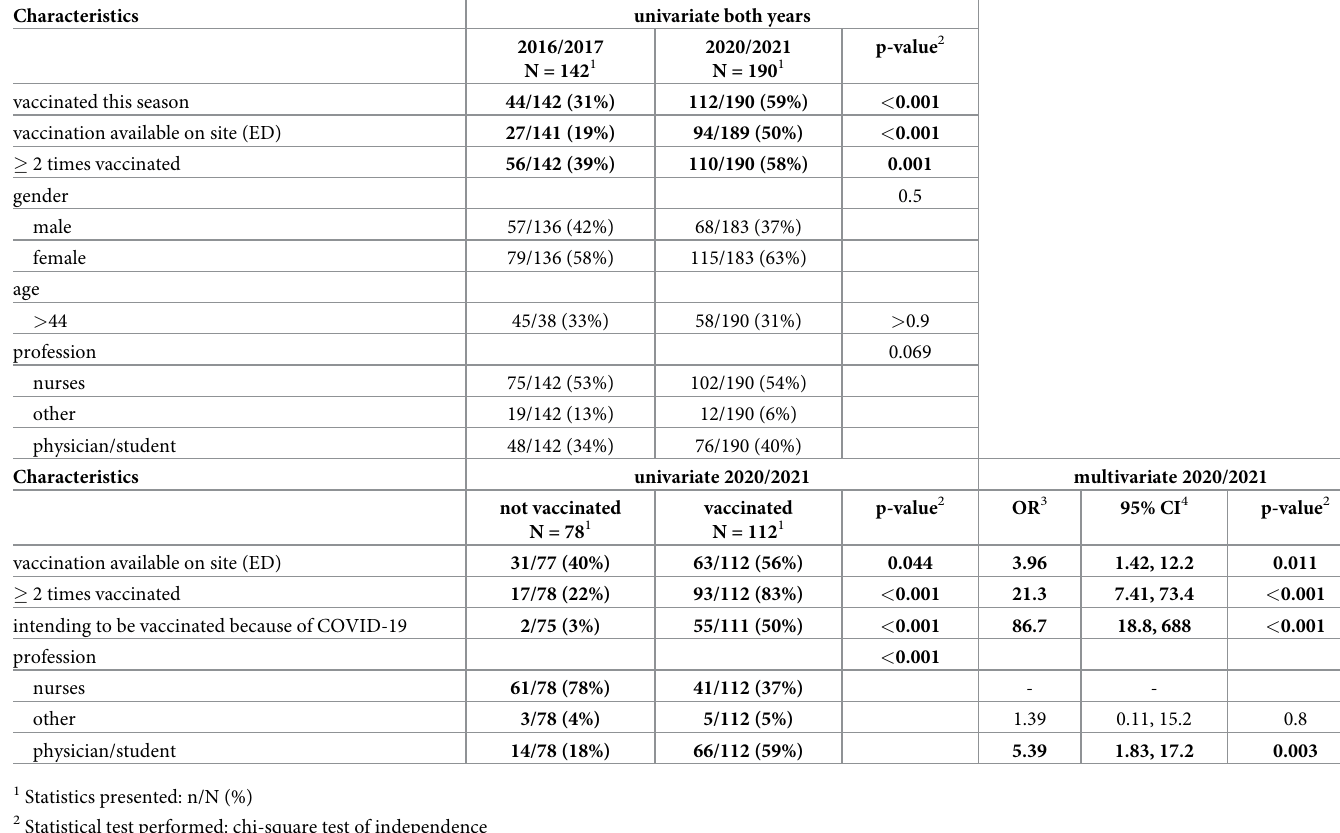
Table 1. Factors associated with influenza vaccination status and socio-demographics of participants.